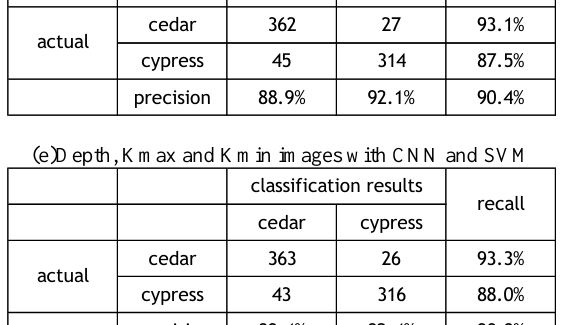
(d)Depth and Kmax images with CNN and SVM